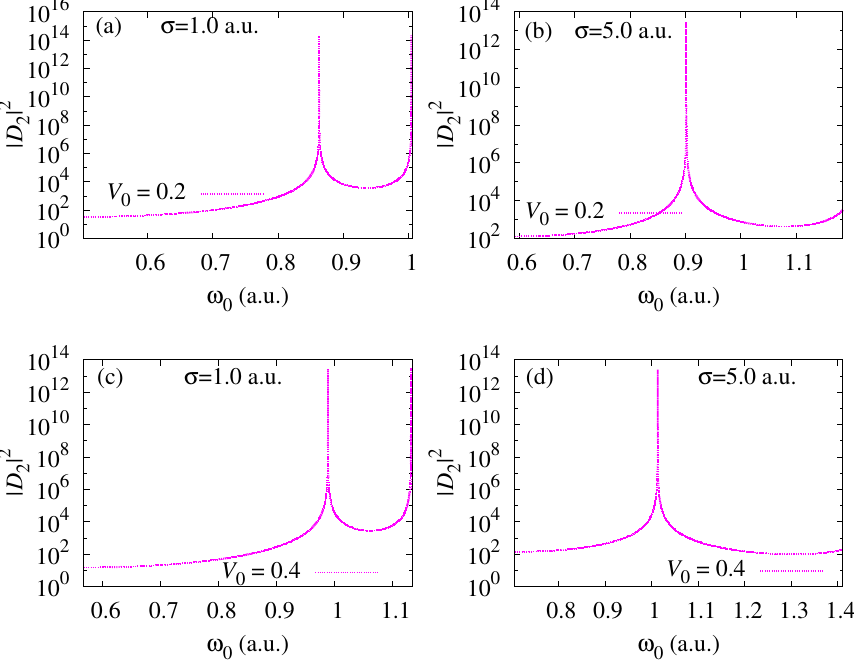
Figure 7. Variation of two-photon 1 s → 3 d absorption coefficients with frequency of incoming photons, ω 0 , for ( a ) V 0 = 0.2 a.u. and σ = 1.0 a.u.; ( b ) V 0 = 0.2 a.u. and σ = 5.0 a.u.; ( c ) V 0 = 0.4 a.u. and σ = 1.0 a.u.; ( d ) V 0 = 0.4 a.u. and σ = 5.0 a.u.